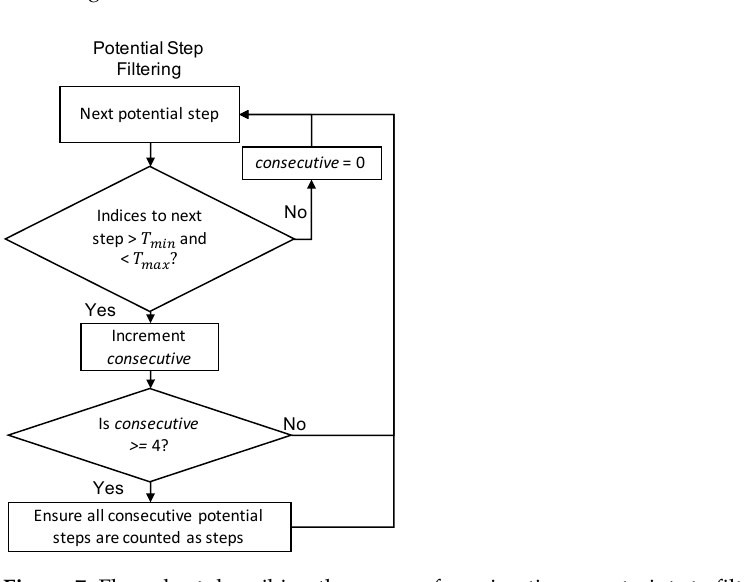
Figure 7. Flow chart describing the process for using time constraints to filter out potential steps for the threshold based